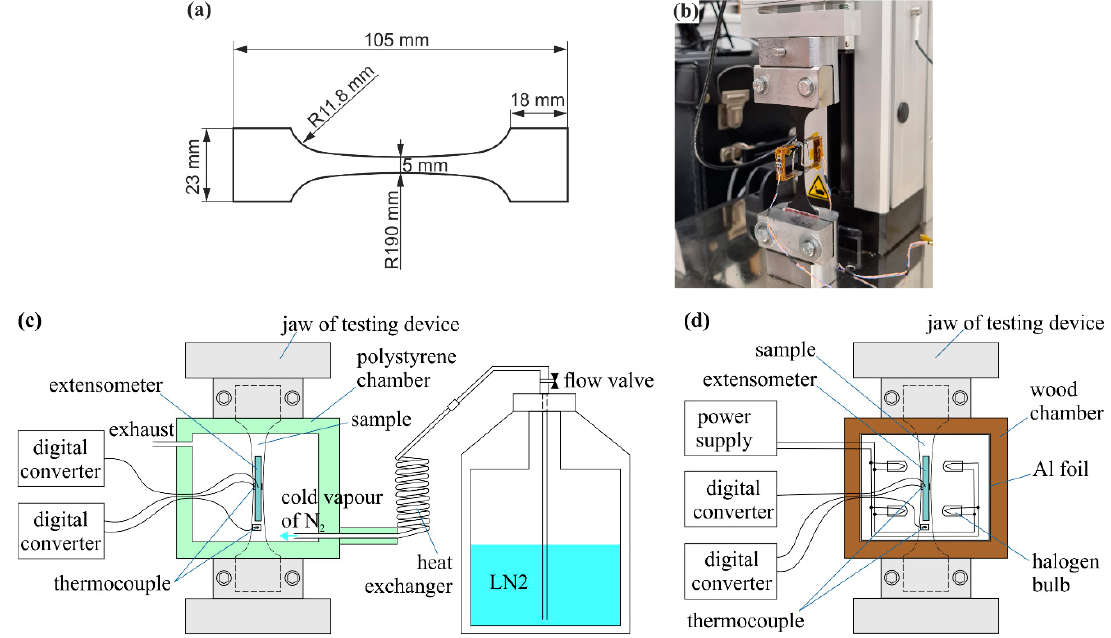
Figure 1. Tensile tests: ( a ) dimensions of a sample in mm; ( b ) tensile test setup with a sample measured at RT; ( c ) scheme of the experimental chamber for low-temperature testing; ( d ) high-temperature testing.